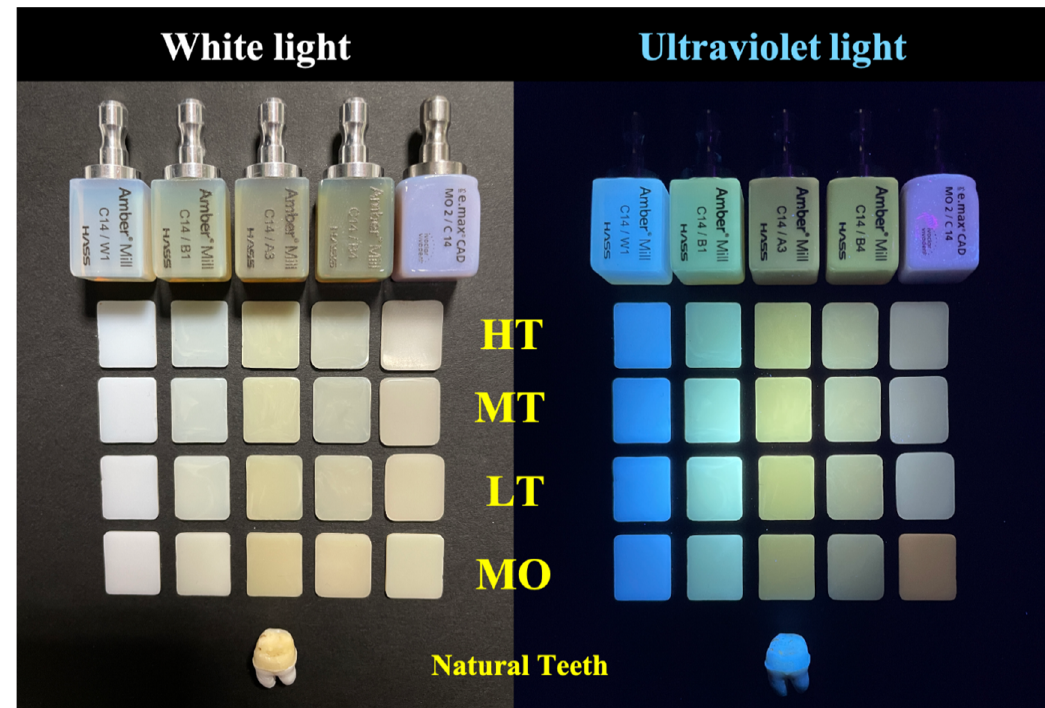
Figure 2. Effects of the opalescence parameter on human teeth and dental glass-ceramics under ultraviolet light (365 nm).